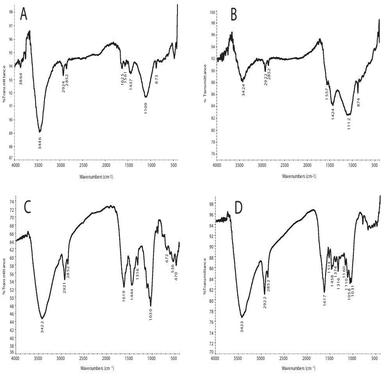
Fourier transform infrared (FT-IR) spectra of A) biochar from red spruce pellets (BCSP), B) biochar from grapevine pruning residues (BCGV), C) hydrochar from urban pruning residues (HCUP) and D) hydrochar from the organic fraction of solid urban wastes (HCSU).